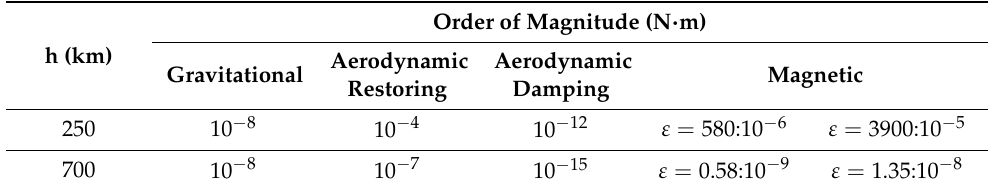
Table 2. Orders of magnitude of the torques acting on the example satellite.